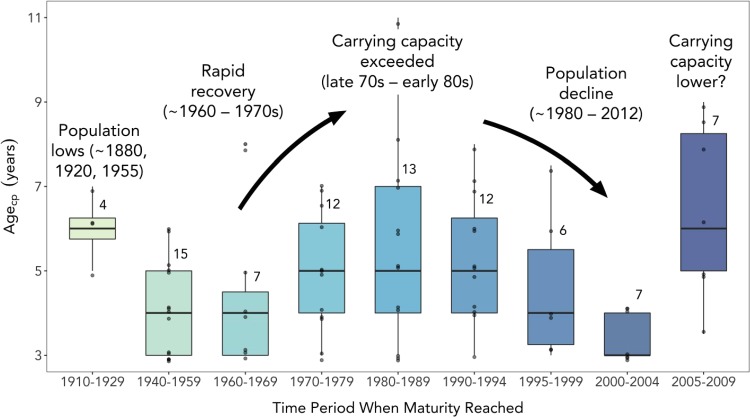
Annotated box plot of changes in agecp of female Pacific walruses over the last ~100 years. Greater sample sizes in more recent years allowed for finer scale division of the data in later decades. Historical changes in the size of the walrus population are noted on the plot and are based on published literature (Fay, 1982; Fay et al., 1997; Garlich-Miller et al., 2011; Speckman et al., 2011; Taylor and Udevitz, 2015; Taylor et al., 2018). Note that average agecp was lower during periods when the walrus population was depleted and higher when walruses were more abundant. Horizontal lines represent group medians, lower and upper bounds of boxes represent the 1st and 3rd quartiles of the data, respectively, and the whiskers represent the full range of the data. Data points more than 1.5 times the interquartile range above or below the median are considered outliers and are represented by individual data points. Sample sizes for each time period are denoted by numbers at the top right of each box.